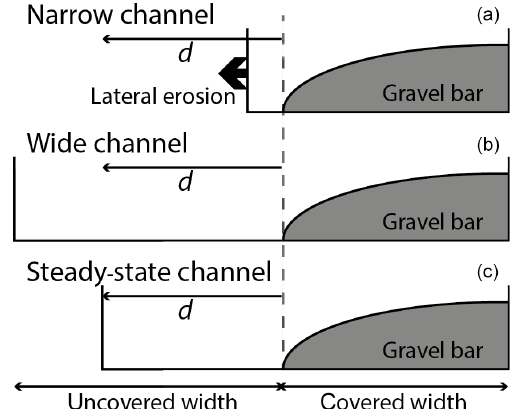
Figure 3. The sideward deflection length scale d interacts with bed cover and channel width to determine whether the lateral erosion occurs (a) or not (b, c) . Adapted from Turowski